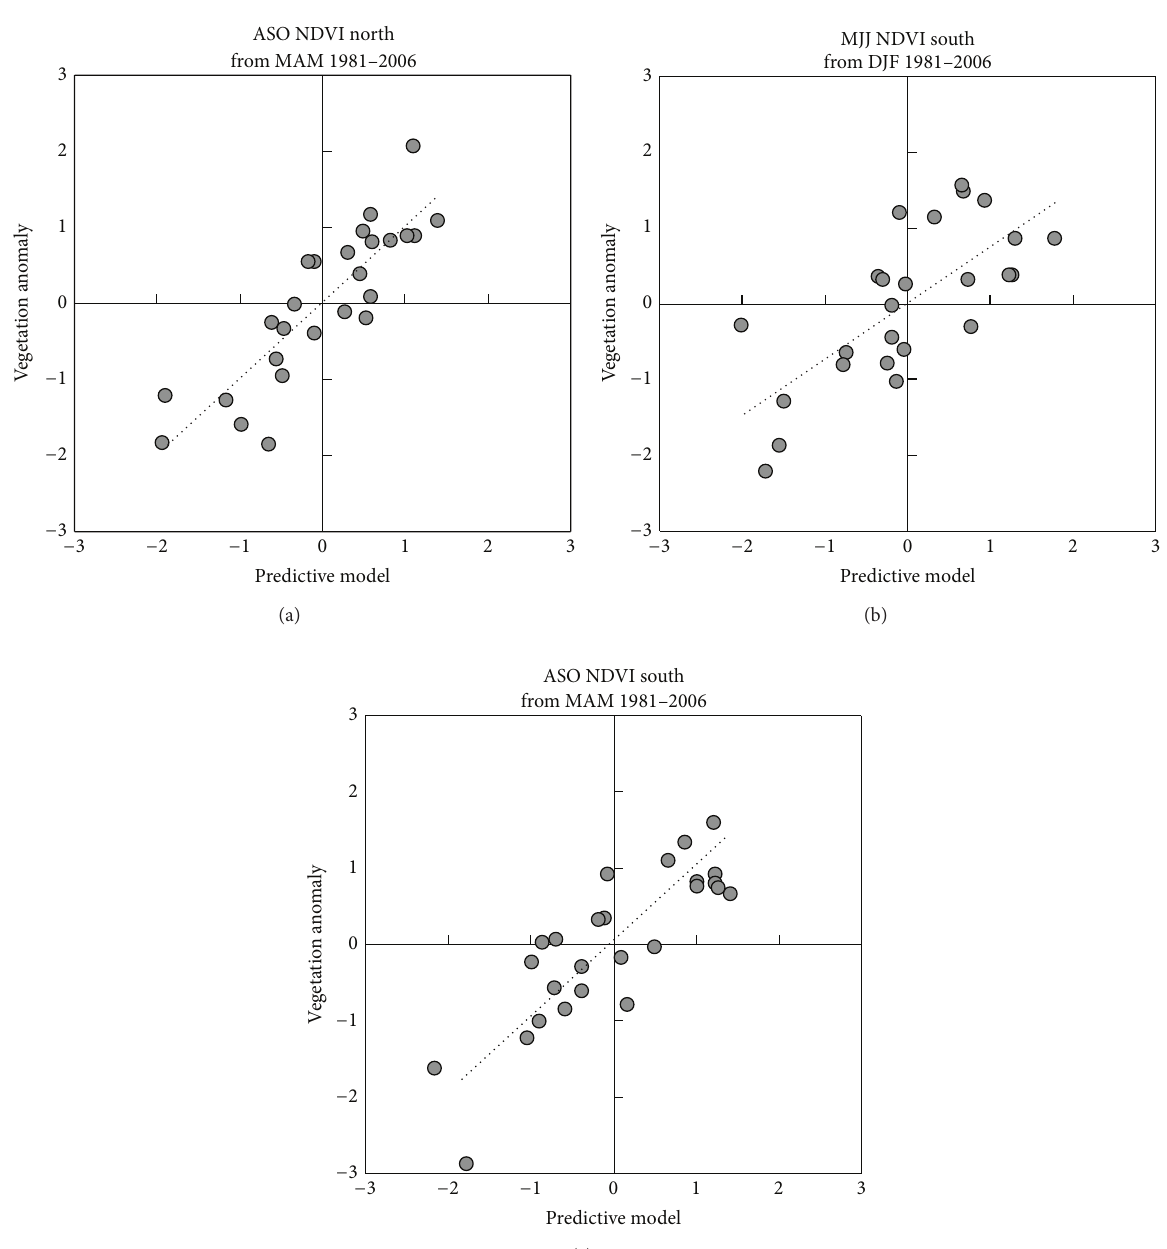
Figure 8: Scatterplots of predicted and observed NDVI vegetation according to Table 1(b), with northern MJJ season omitted.